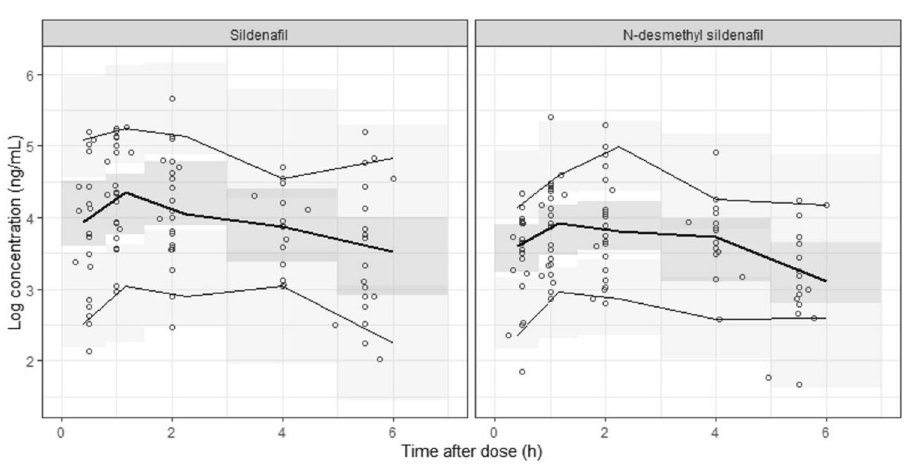
Figure 3. Prediction-corrected visual predictive check for sildenafil and N-desmethyl sildenafil. The solid lines represent the 5th, 50th, and 95th percentiles of the observed data. The shaded areas represent the 90% confidence interval of the 5th, 50th, and 95th percentiles of the predicted